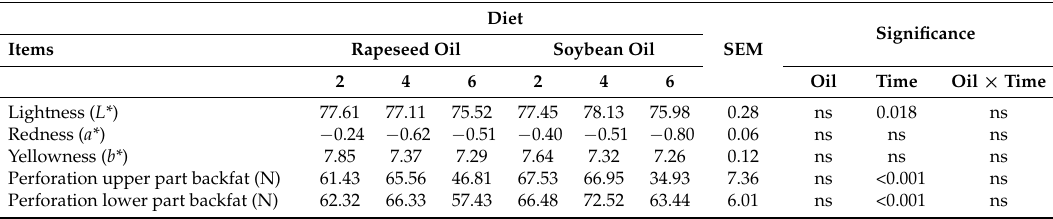
Table 3. Physical characteristics of